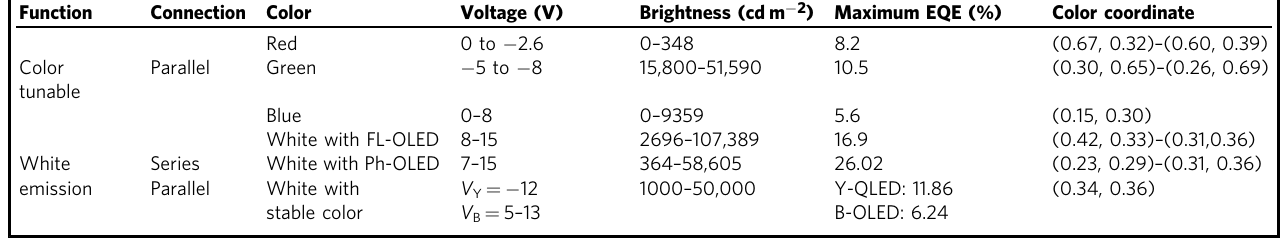
Table 1 The performances of the multifunctional tandem LED.